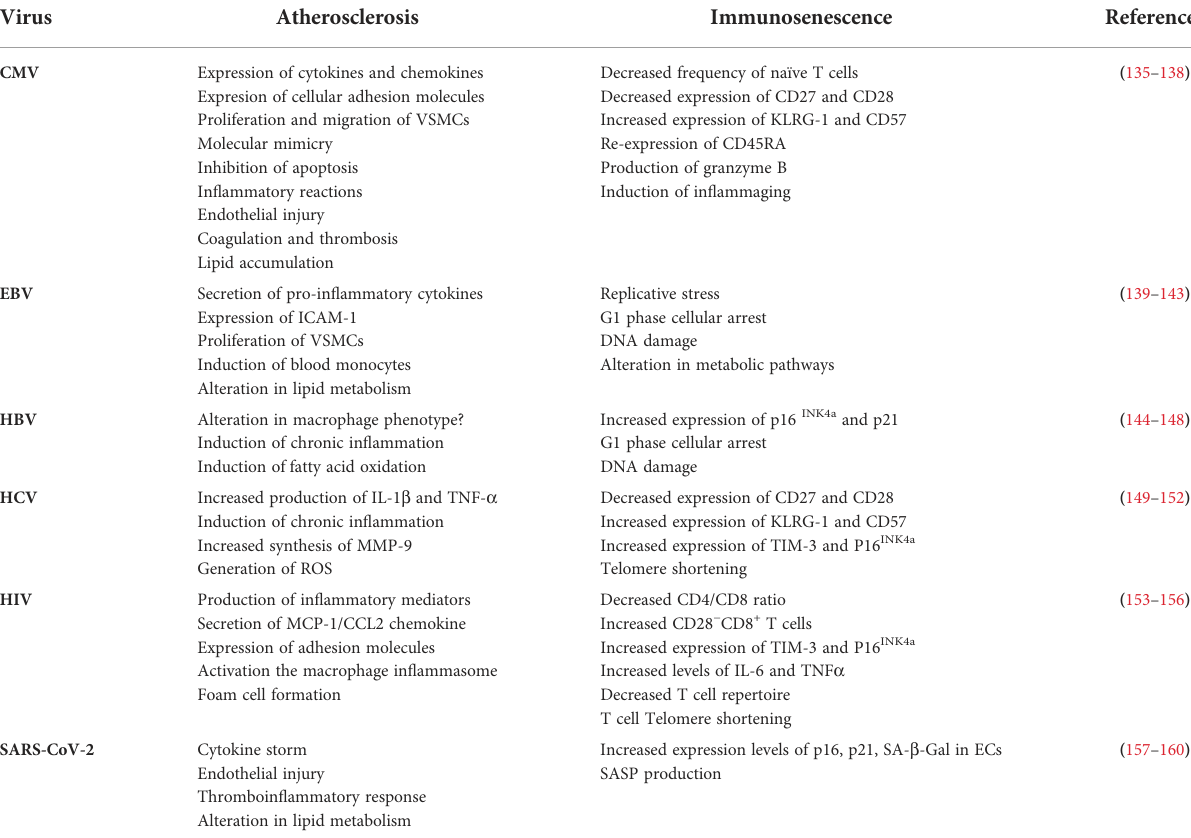
TABLE 1 Induction of atherosclerosis and immunosenescence by different